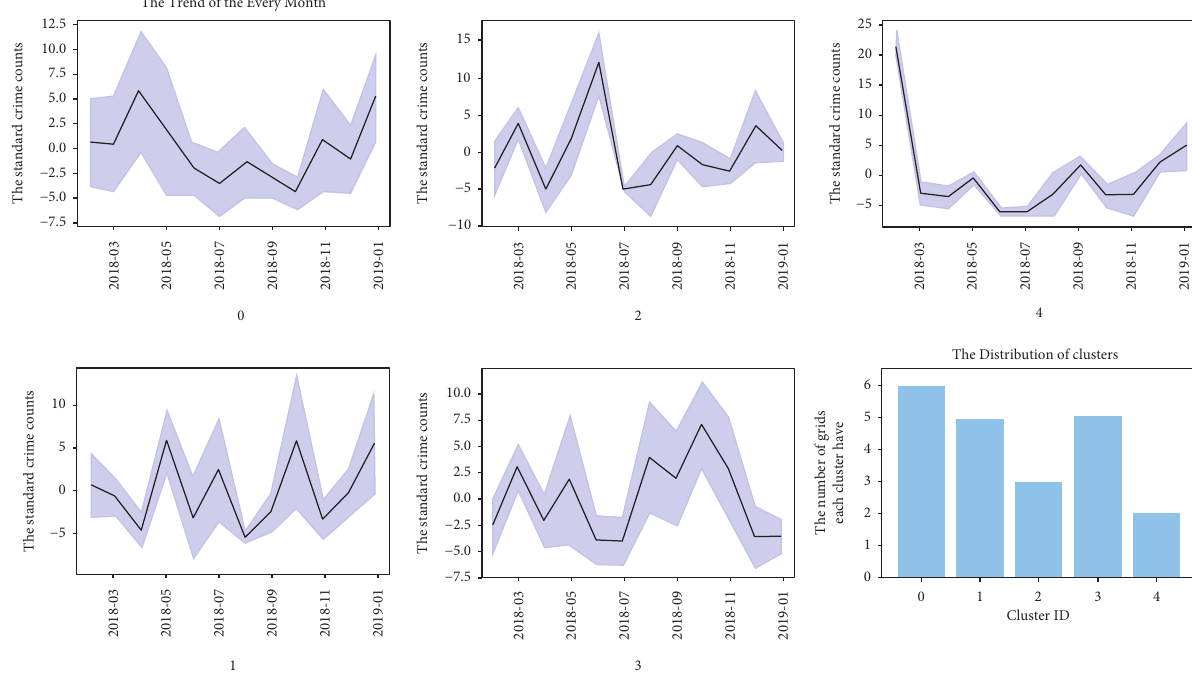
Figure 12: The burglary in Santa Monica trends in each month in 2018 and the distribution of clusters. The line charts are the monthly trends of burglary in Santa Monica in 2018. The bar chart is the distribution of the